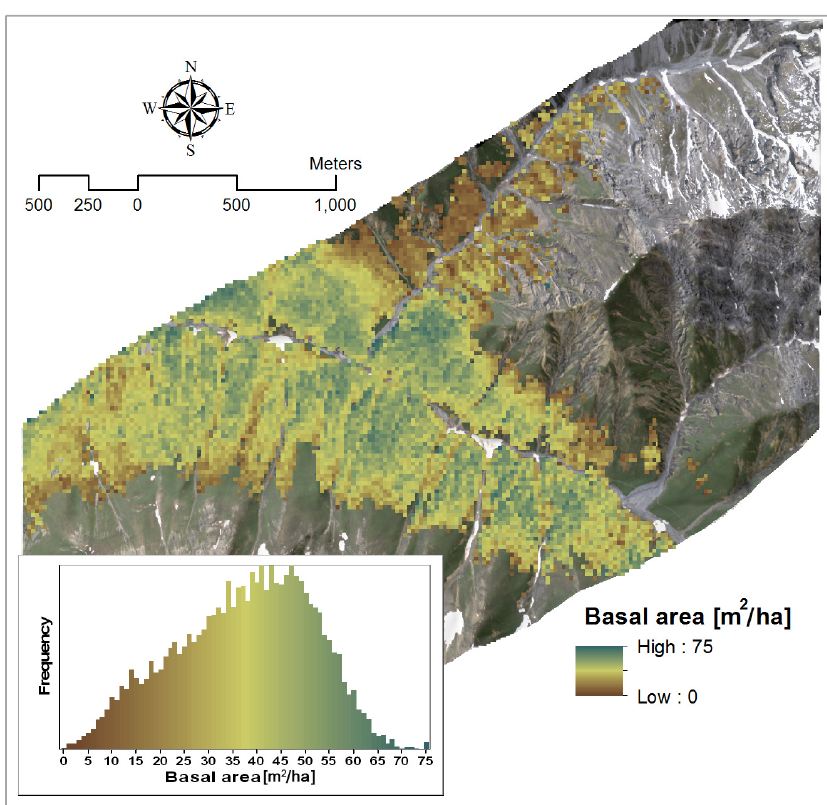
Figure 4. Predicted map of forest basal area in Val Trupchun; an APEX true color composite is used as background.